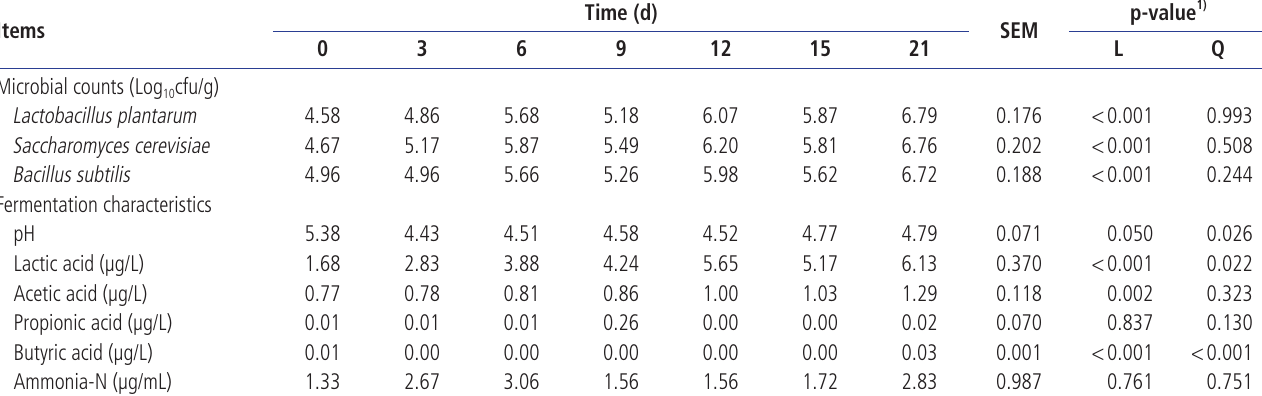
Table 5. Changes of microorganism counts and fermentation characteristics in spent instant coffee grounds according to fermentation periods Items Microbial counts (Log cfu/g) 10